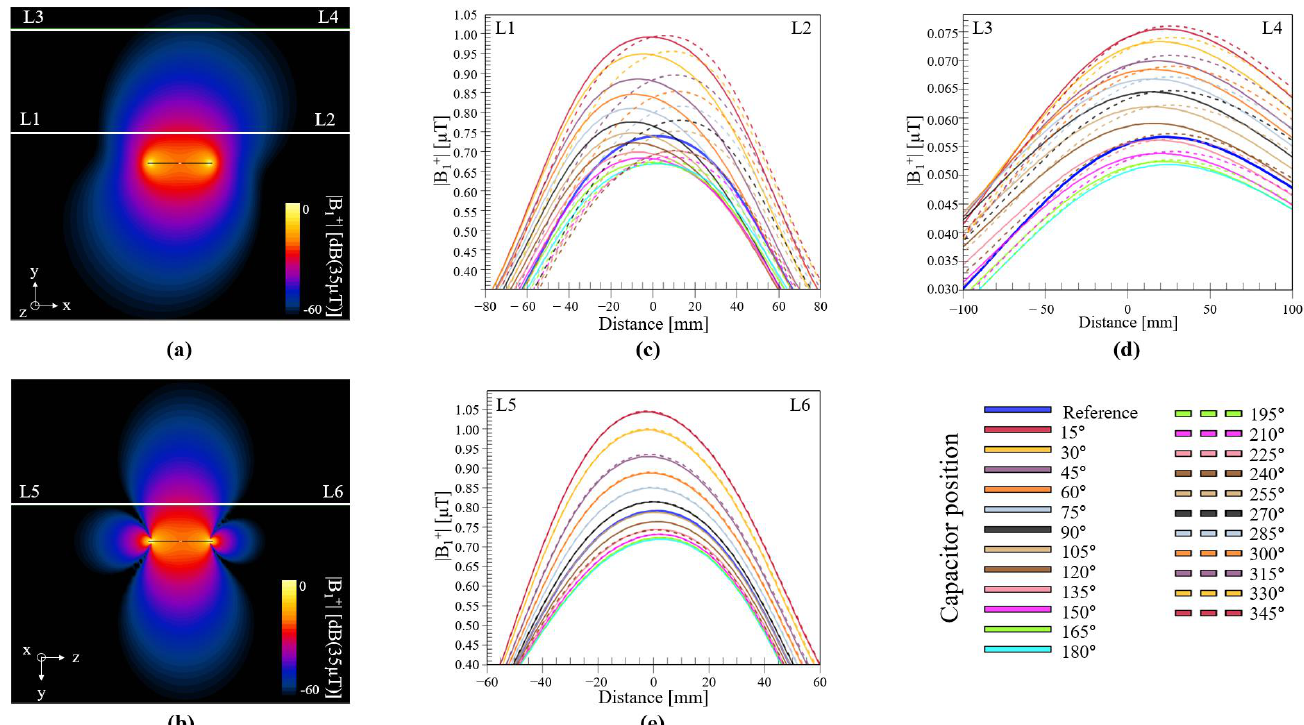
Figure 5. Computed |B 1+ | field in empty space in ( a ) XY plane and ( b ) YZ plane. ( c ) Plots of L1 – L2 profile lines, ( d ) L3 – L4 profile lines, and ( e ) L5 – L6 profile lines, for all coil configurations.